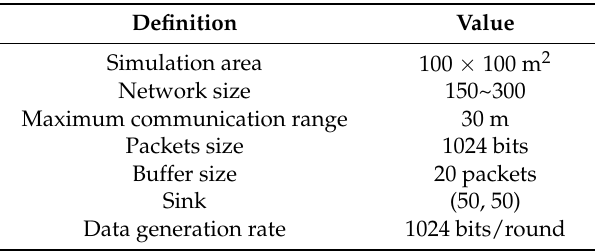
Table 1. Simulation